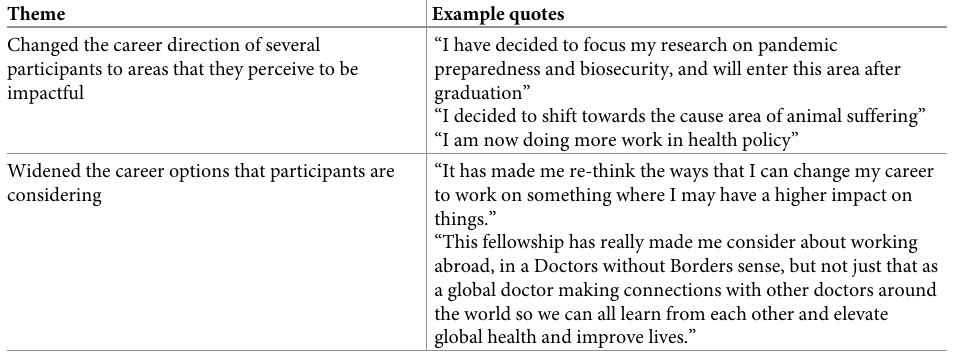
Table 8. Participant responses about how the fellowship changed their perception of their